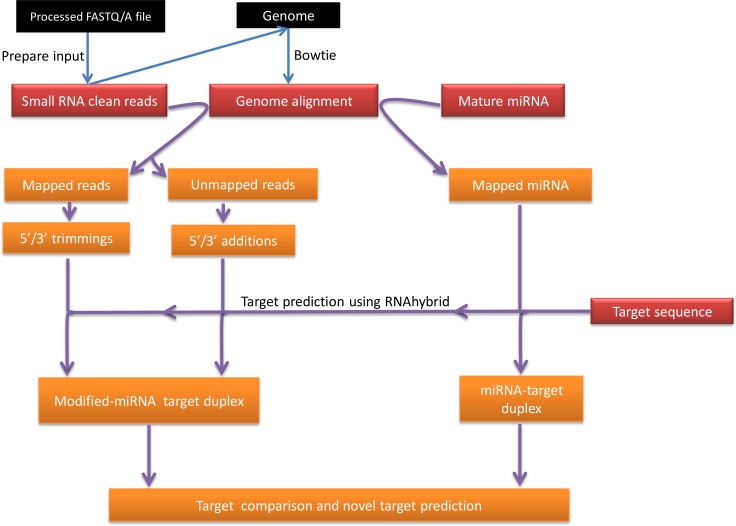
miRMOD workflow.